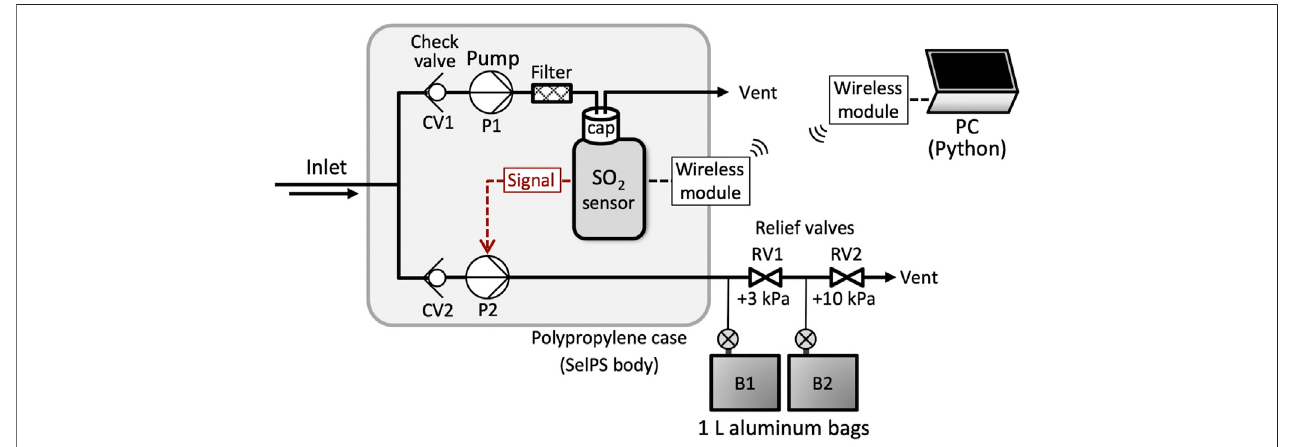
FIGURE 1 | The internal fl ow diagram of the plume sampler SelPS (modi fi ed from Shingubara et al., 2021). Gas samples drawn in at the gas inlet were partitioned into twolines inparallel, each ofwhich wasconnected toadiaphragmpump (DP0125, NittoKohki Co.,Ltd., Japan). Pump P1,running continuously throughout a fl ight, introduced gas at a fl ow rate of approximately 0.5 L/min to a fi lter (ZFC33, SMC Corp., Japan) and subsequently to an electrochemical SO 2 sensor (ToxiRAE Pro EC PGM-1860, RAE Systems Inc., United States), which continuously measured SO 2 concentrations. A wireless module was newly added to monitor the real-time SO 2 concentration during fl ights and thus obtain more concentrated volcanic plume samples through the precise adjustment of the hovering position.